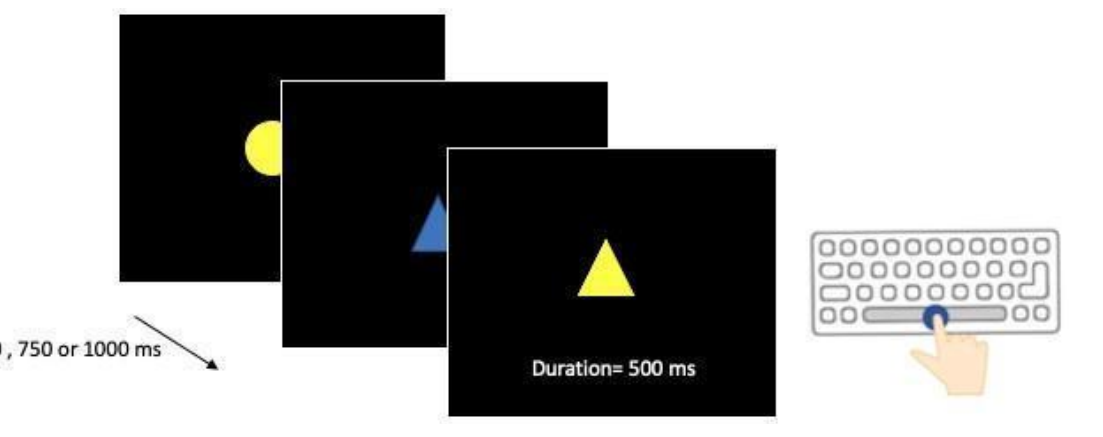
Figure 1. Exemplification of Go/NoGo task.